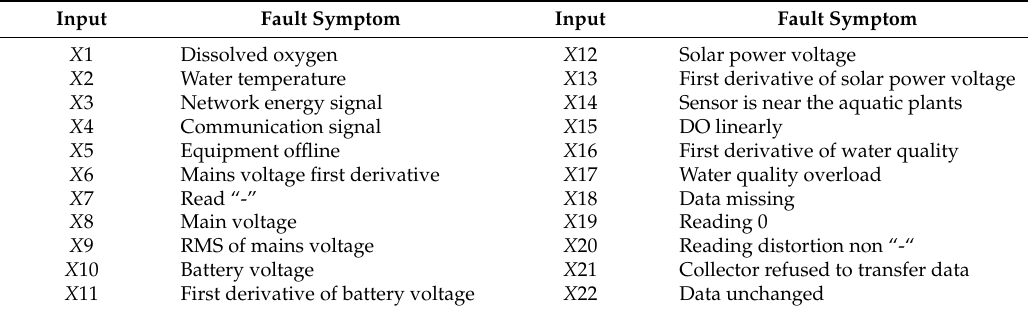
Table 2. The inputs of the fuzzy neural network.